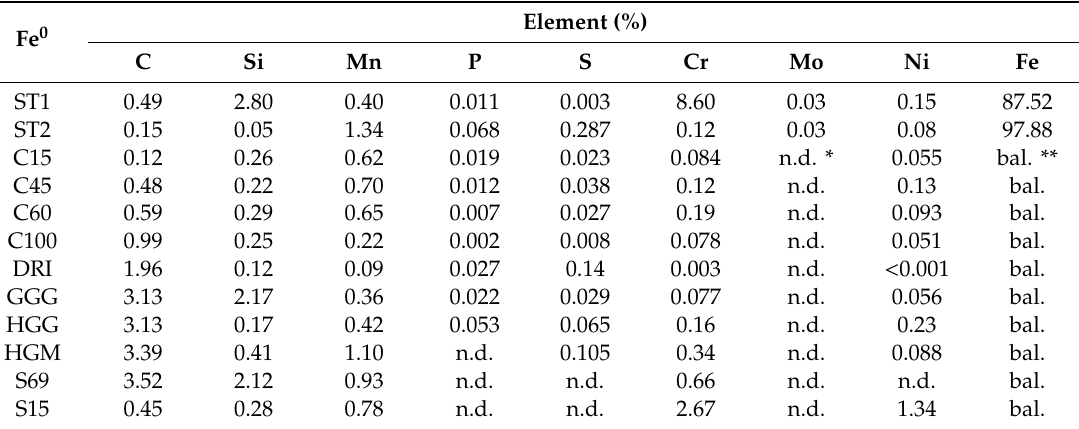
Table 3. Elemental composition of iron materials used in this